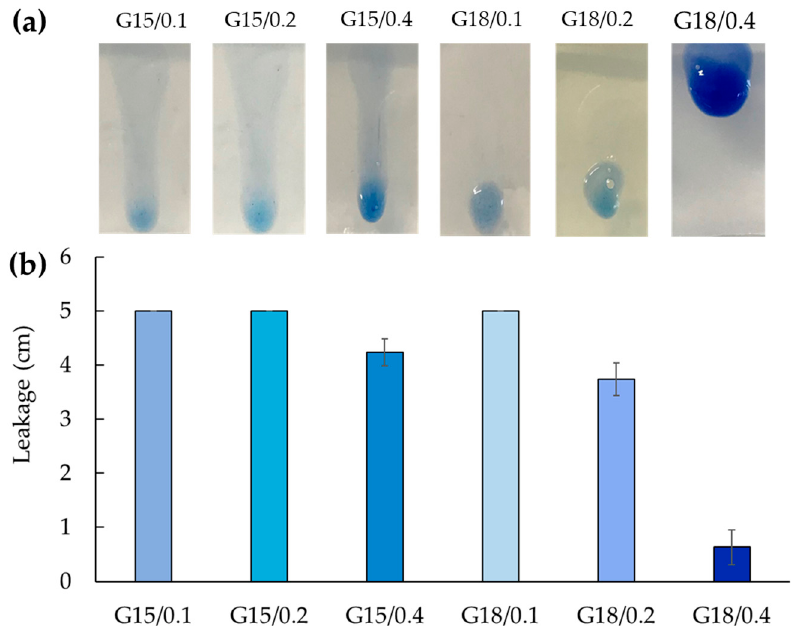
Figure 4. Comparative leakage test performed on formulations colored by Coomassie blue dye for imaging. Images ( a ) and leakage distances ( b ) were taken 10 s after placing the formulations on the slides. Data are the mean of three experiments ± s.d.